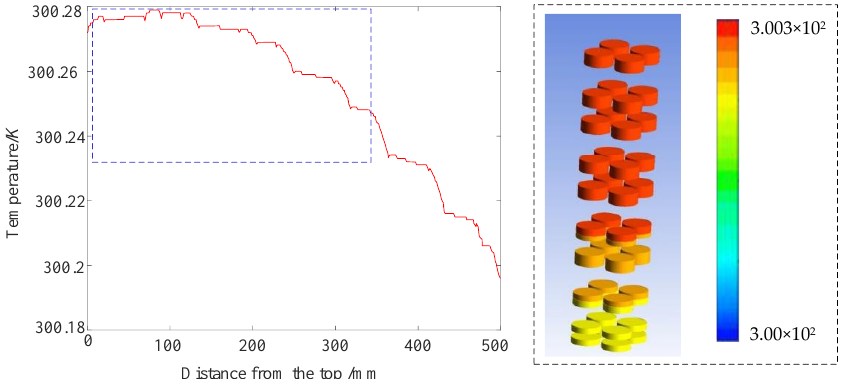
Figure 9. Axial temperature distribution of the valve blade under monopole earth loop operation